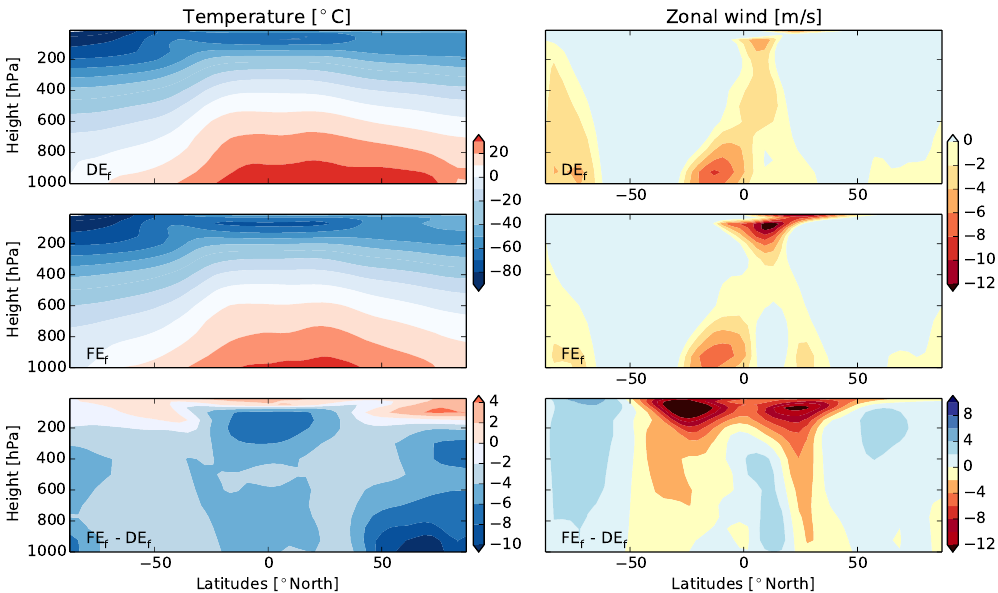
Figure 7. Zonal-mean temperature and wind in the desert world simulation, DE f , and in the forest world, FE f , simulation of the early Eocene climate. Moreover, the differences between the forest world simulation and the desert world simulation (FE f –DE f ) is shown. The average of July and August in the last 30 years of the simulations is